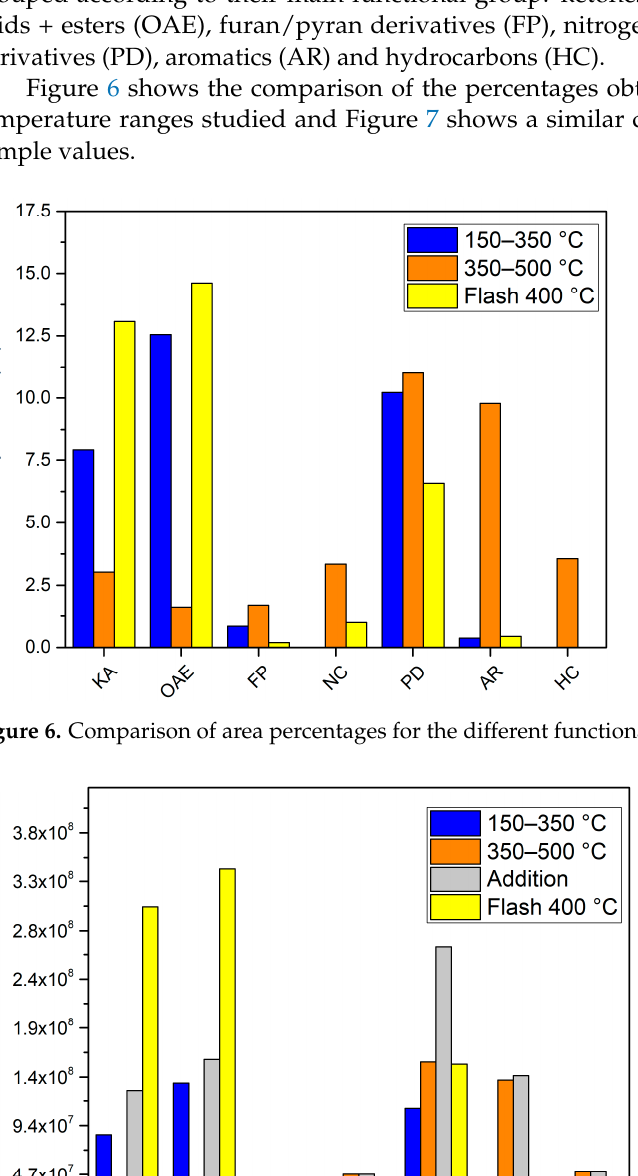
Figure 7. Comparison of area/mg sample values for the different functional groups.